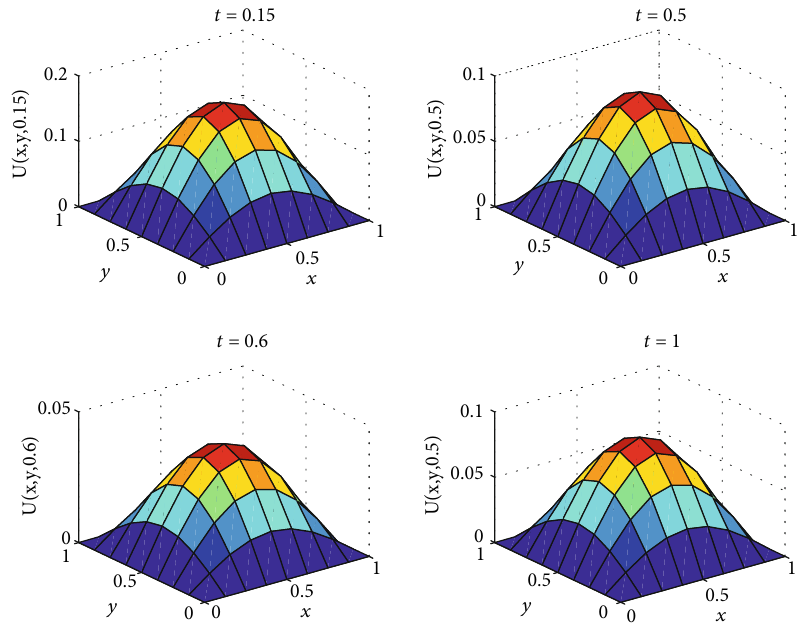
Figure 3: Temperature images at di ff erent times when D = 1 , ε 2 = 0 : 1 , h = 1/16 , and τ = 1/80 .